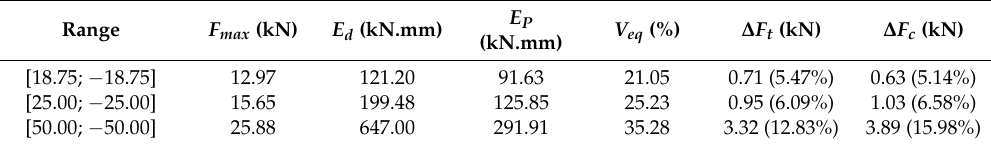
Table 2. Results of the cyclic test DHC. Impairment strength ( Δ F ).